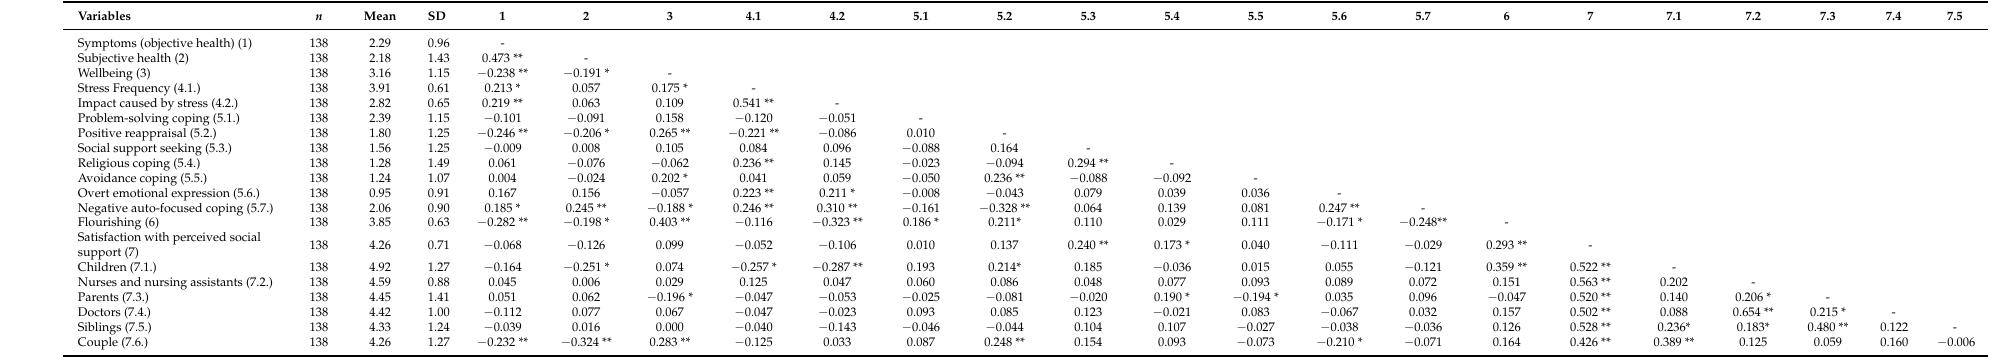
Table 2. Screening on the psychosocial functioning in parents of children with cancer: Correlation between the analyzed